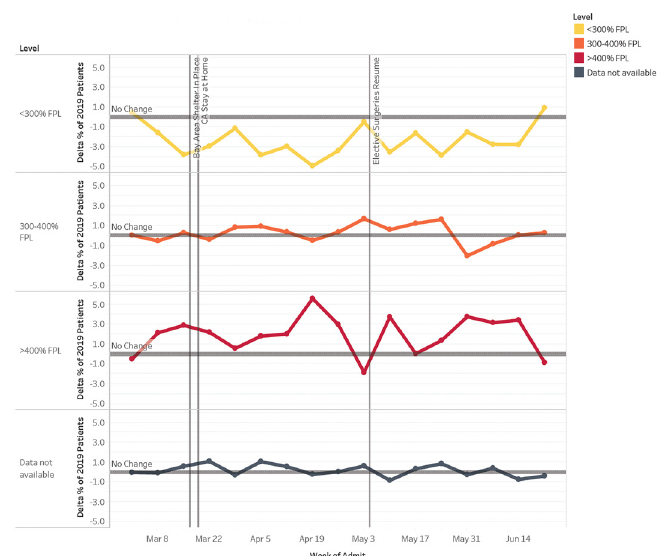
Figure 5. Change in proportion of patients by federal poverty level categories for weekly ED visits in 2020 compared to